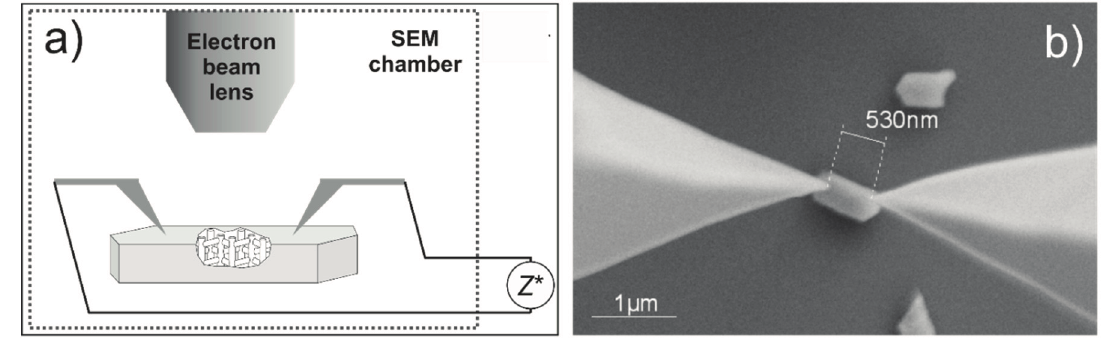
Figure 19. ( a ) Measuring configuration for electric measurement on single zeolite crystal; ( b ) H-ZSM-5 crystal electrically contacted by two metallic tips. The spacing between the tips in ( b ) is about 530